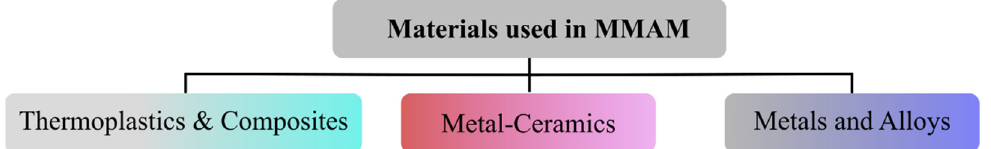
Figure 14. Material categories used in MMAM